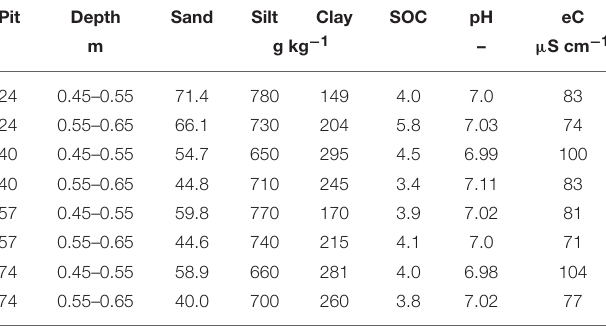
TABLE 2 | Number of investigated samples of biopores colonized and/or created by chicory ( Cichorium intybus L. ) roots (R), colonized and/or created by Lumbricus terrestris (EW), and biopores colonized and/or created by a plant root followed by colonization of L. terrestris (REW) for samples from Bt-1 (0.45–0.55m soil